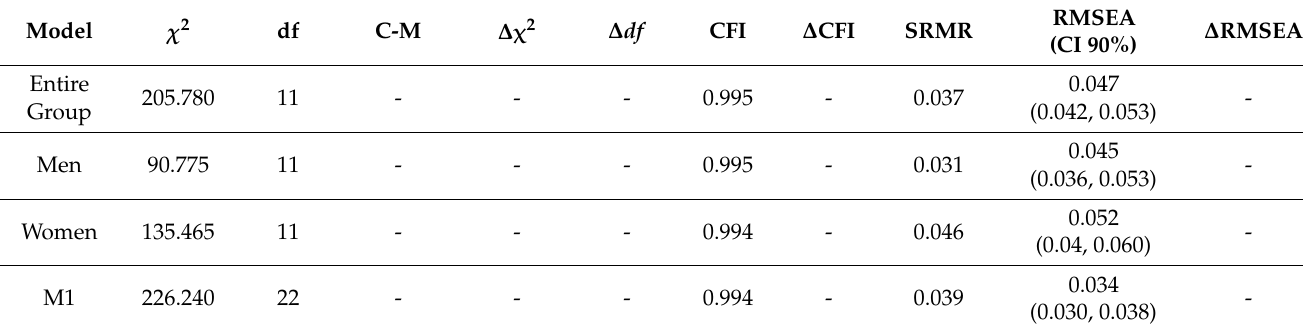
Table 3. AAQ-II factorial invariance for the total sample and by